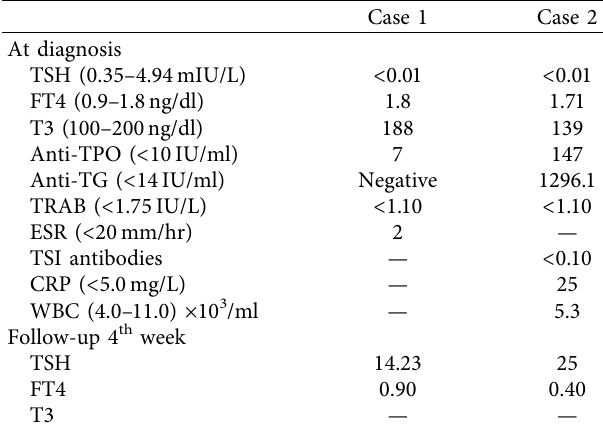
Table 1: Laboratory test